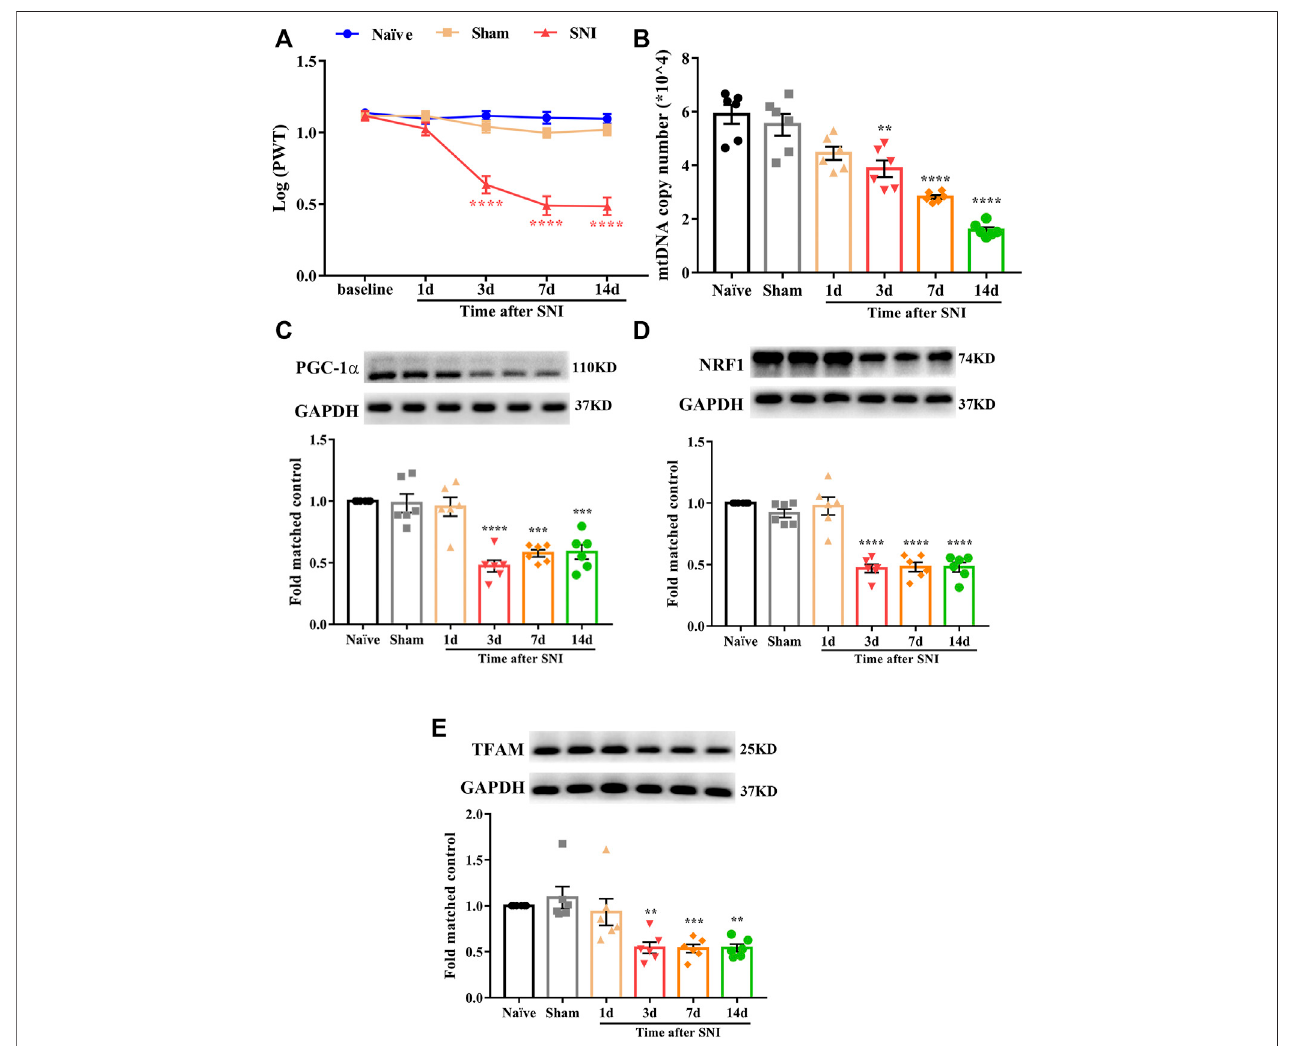
FIGURE 1 | Mechanical allodynia induced by spared nerve injury and mitochondrial biogenesis was impaired in the spinal cord of neuropathic pain rats. (A) Paw withdrawal threshold (PWT) was assessed to evaluate the developmentof mechanical allodynia at baseline and 1, 3, 7, and 14days after surgery. There is no signi fi cant difference regarding the PWT among naïve, sham, and SNI group at baseline. However, the PWT in SNI rats was markedly decreased from day 3 to day 14 (**** p < 0.0001 compared with sham group, n = 10 in each group). In contrast, the PWT in sham rats had no signi fi cant change during the observation period. (B) MitochondrialDNA(mtDNA)copynumberwassigni fi cantlyandtimedependentlydecreasedinSNIrats,beginningatday3aftersurgeryandremainatlowleveluntilday 14(** p < 0.01,**** p < 0.0001comparedwithshamgroup,n=6ineachgroup). (C) PGC-1 α wassigni fi cantlydecreasedinSNIrats,beginning atday3aftersurgeryand remainatlowleveluntilday14(*** p < 0.001,**** p < 0.0001comparedwithshamgroup,n=6ineachgroup). (D) NRF1wassigni fi cantlydecreasedinSNIrats,beginning at day 3 after surgery and remain at low level until day 14 (**** p < 0.0001 compared with sham group, n = 6 in each group). (E) TFAM was signi fi cantly decreased in